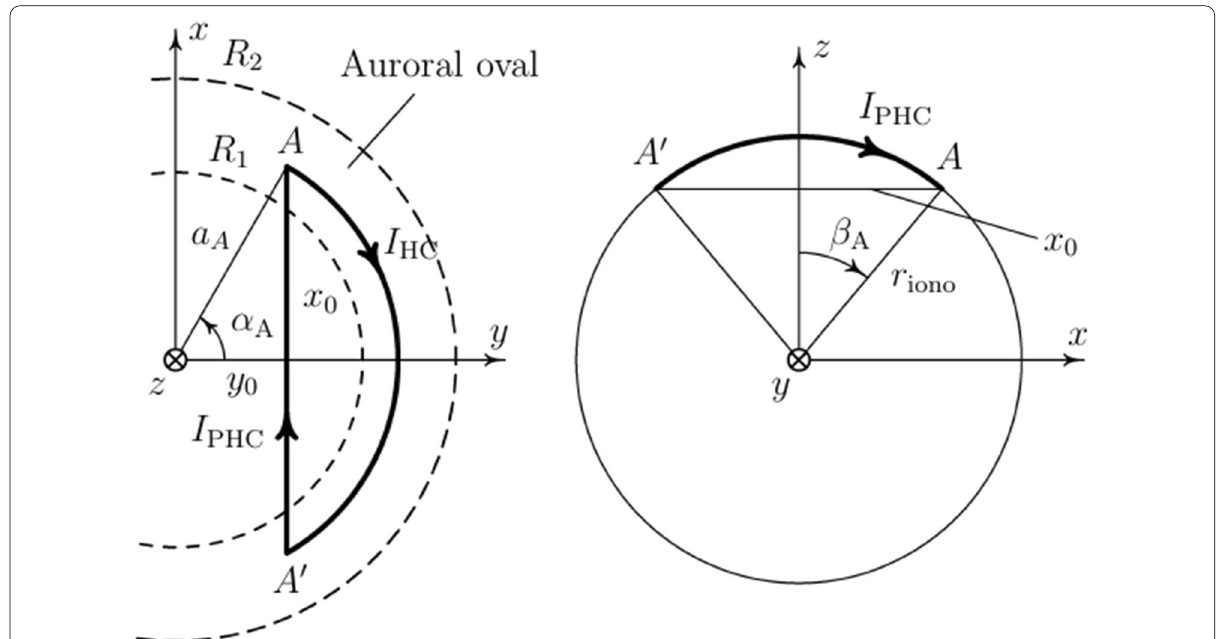
Fig. 18 The geometry considered to derive the magnetic field generated by a wire lying in y = y 0 plane and carrying the polar-cap Hall current I PHC along a circular arc between points A and A ′ . The left and right panels show the projections onto the z = z 0 and y = y 0 planes, respectively, where z 0 = r iono cos ϑ A , a A = r iono sin ϑ A (see Fig. 17) and y 0 = a A cos α